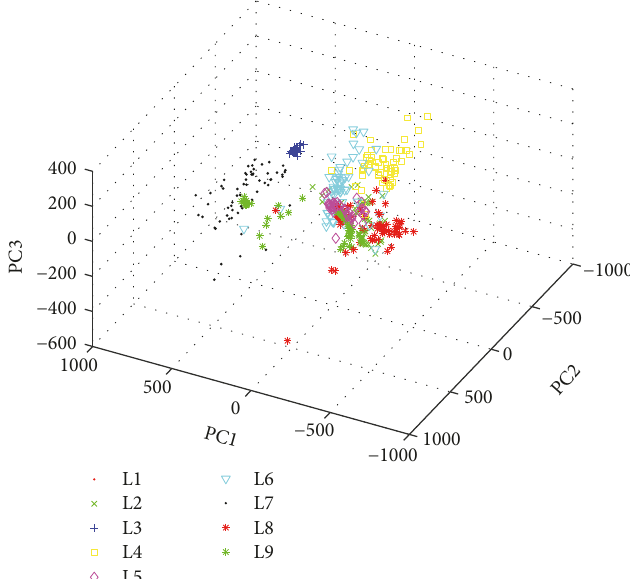
Figure 7: 3D projection of feature vectors for different faults.